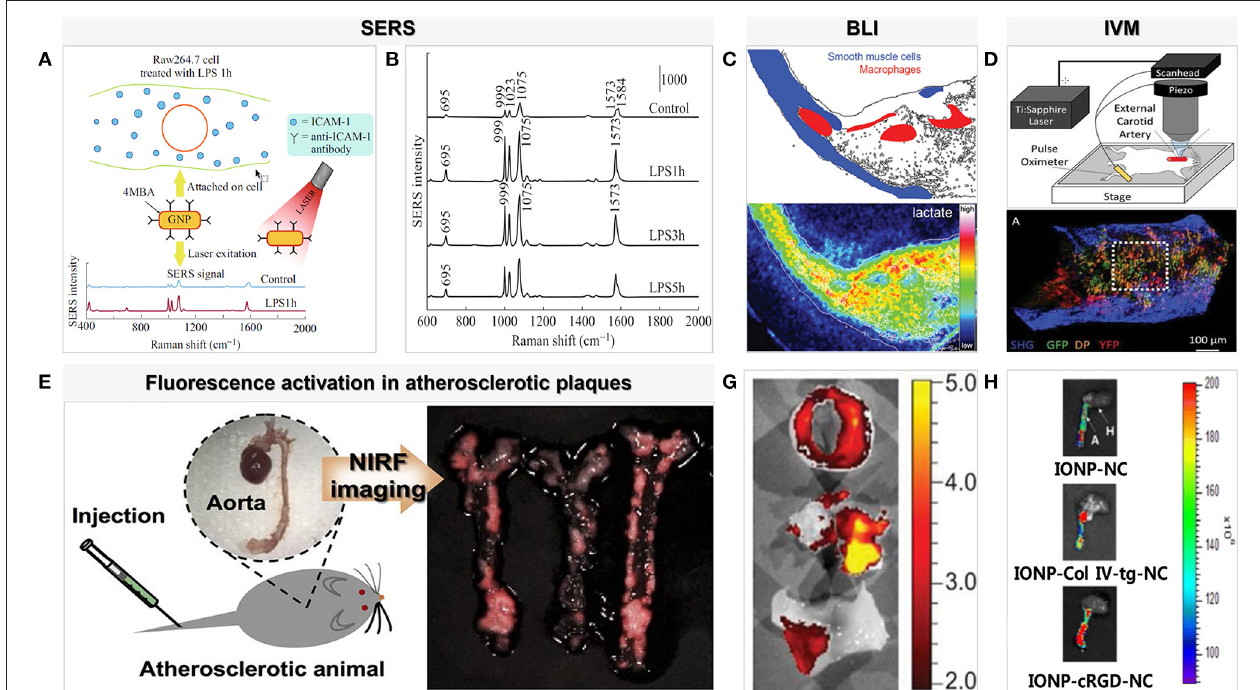
FIGURE 2 | Examples of surface-enhanced Raman spectroscopy and optical imaging for macrophages in atherosclerosis. (A) SERS probe GNR techniques for detection of adhesion molecules expressed on the surface of macrophage cells (Raw264.7) [adapted from ( 14)]. (B) SERS spectra detected from Raw264.7 cells treated with LPS for different lengths of time (1, 3, and 5h). The SERS spectra were averaged from ∼ 80 to 235 spectra detected for each condition [adapted from ( 14)]. (C) Bioluminescence metabolic imaging showed energy metabolism in shoulder region of human atherosclerotic lesion in the common carotid artery [adapted from (16)]. (D) An aorta explanted from an Apoe − / − Cx3cr1GFP/ + CD11cYFP mouse fed WD and imaged with two-photon microscopy shows GFP, DP, and YFP cells in the wall [adapted from ( 17)]. (E) NIRF imaging of atherosclerotic plaques in ApoE KO mice. P-ICG2-PS-Lip was intravenously injected into ApoE KO mice via a tail vein, and the images were obtained by using a Maestro fluorescence imaging system [adapted from ( 18)]. (G) Ex vivo imaging with GB123 in human carotid plaque (above: unstable plaque + inhibitor, middle: unstable plaque, below: stable plaque) revealed high cathepsin activity, in yellow, was found in probe-treated unstable plaques [adapted from ( 19)]. (H) NIR fluorescence images of collected aorta from ApoE KO mice after 24h injection of IONP-cRGD-NC, IONP-Col IV-tg-NC, IONP-NC [adapted from